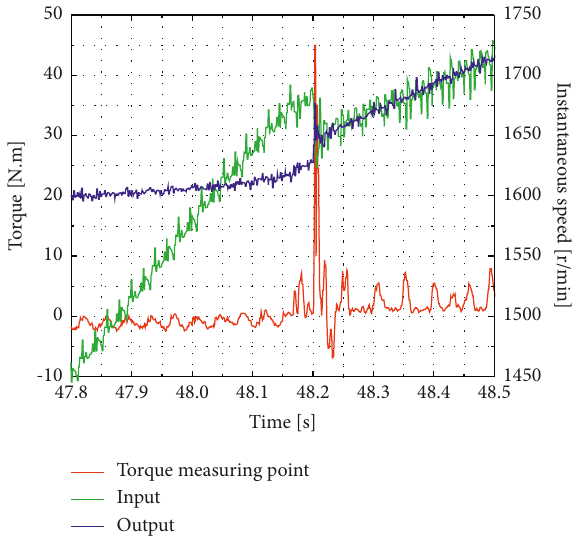
Figure 12: Transient torque and transient rotational speed of the SSS clutch.